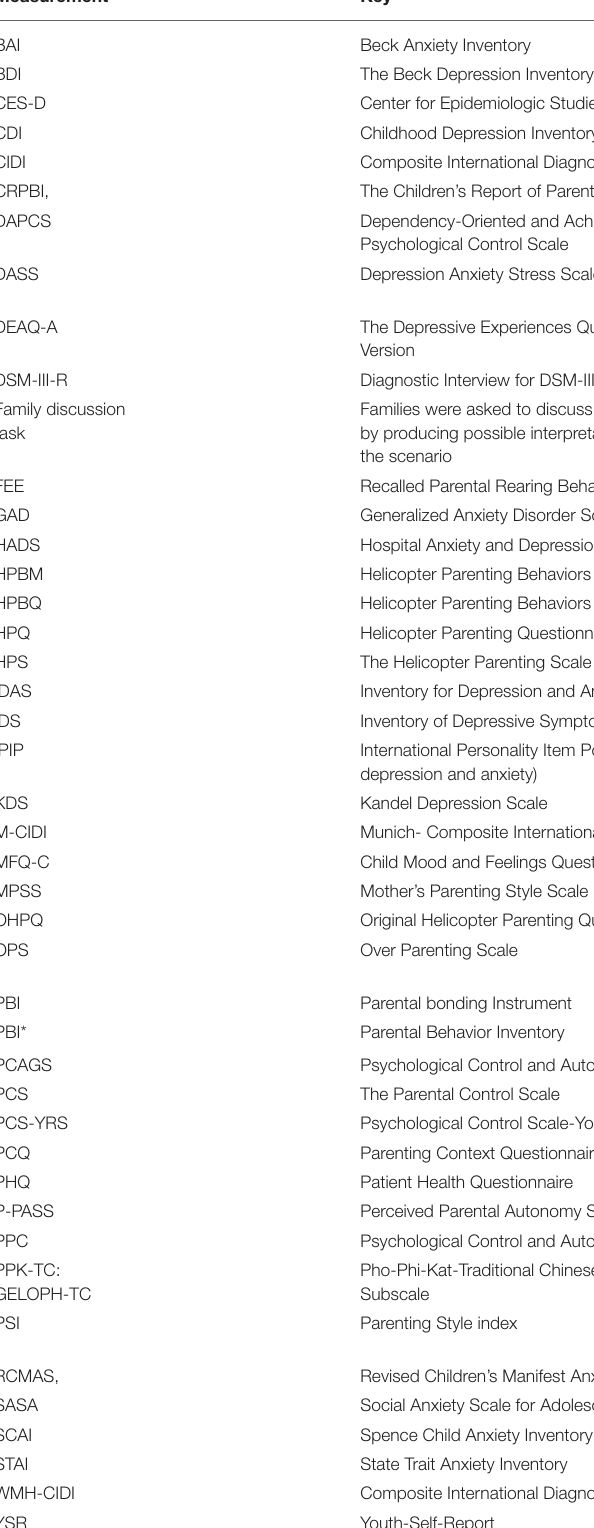
TABLE 3 | Overview of measurements used in the included studies.